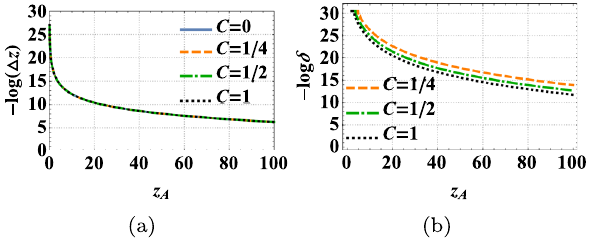
Fig. 2 The deviation between the source redshifts given by the EMW observation ( z (cid:4) ) and GW observation ( z A ). a The relative deviation A (cid:17) z with respect to the source redshift z A . The parameter C is set to C = 0 (blue solid curve), C = 1 / 4 (orange dashed curve), C = 1 / 2 (green dashed and dotted curve), and C = 1 (dark dotted curve). b The parameter δ with respect to the source redshift z A . The parameter C is set to C = 1 / 4 (orange dashed curve), C = 1 / 2 (green dashed and dotted curve), and C = 1 (black dotted curve) − z ∼ 0 . 001. When the source z A is of the order z (cid:4) A A